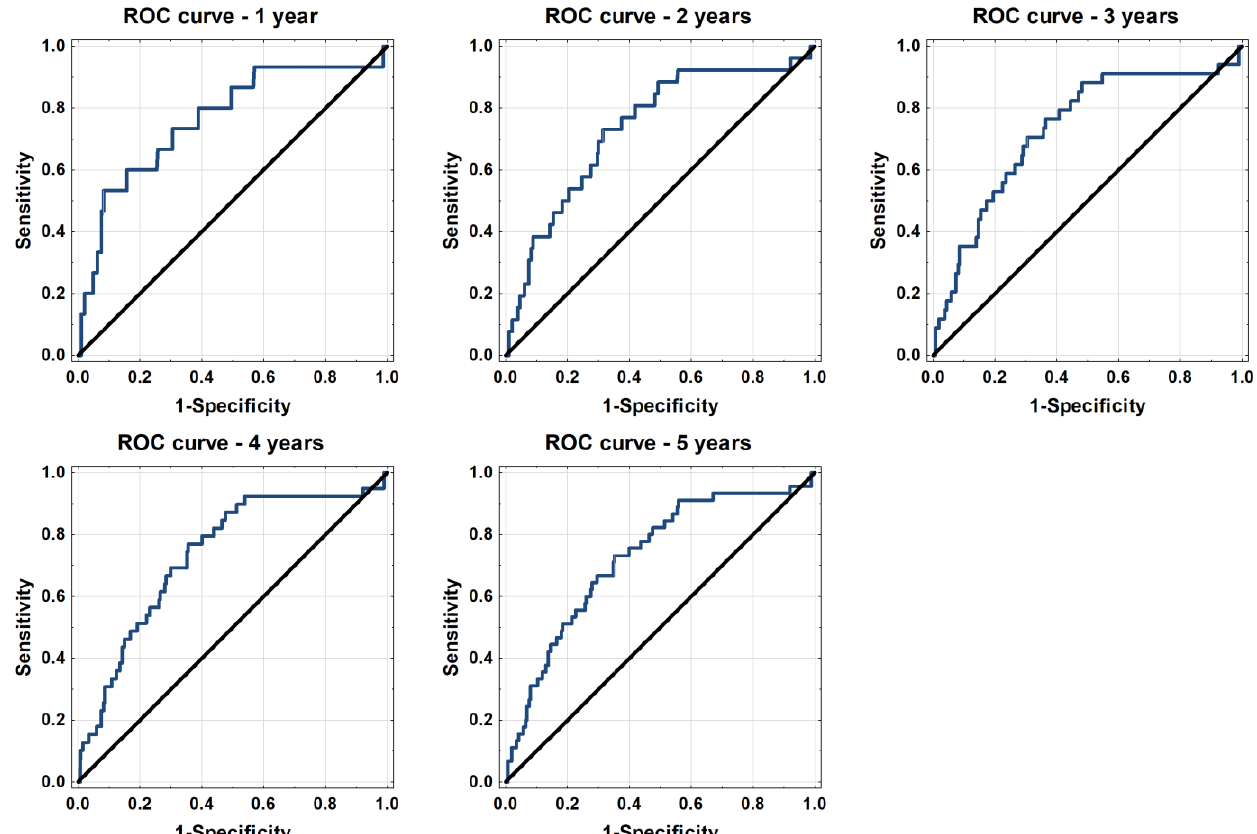
Figure 1. ROC curves for the performance of the Krakow DCM Risk Score.